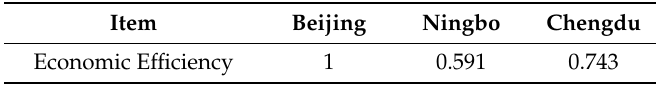
Table 13. Comparison of economic efficiency of three city ADNs.